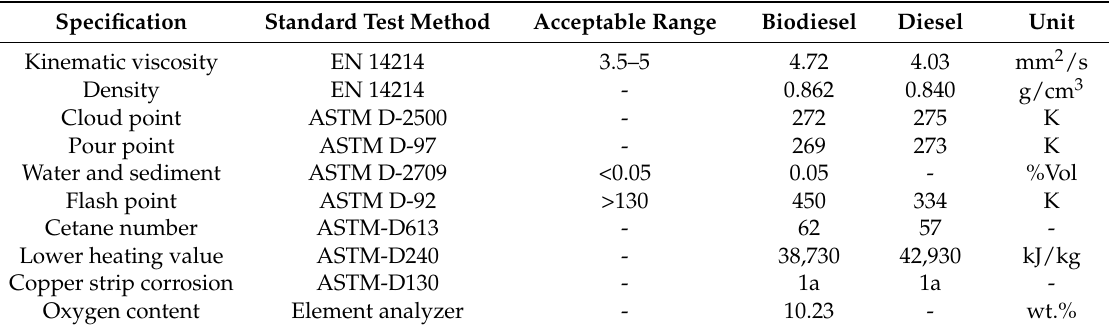
Table 1. Some important properties of the fuels.